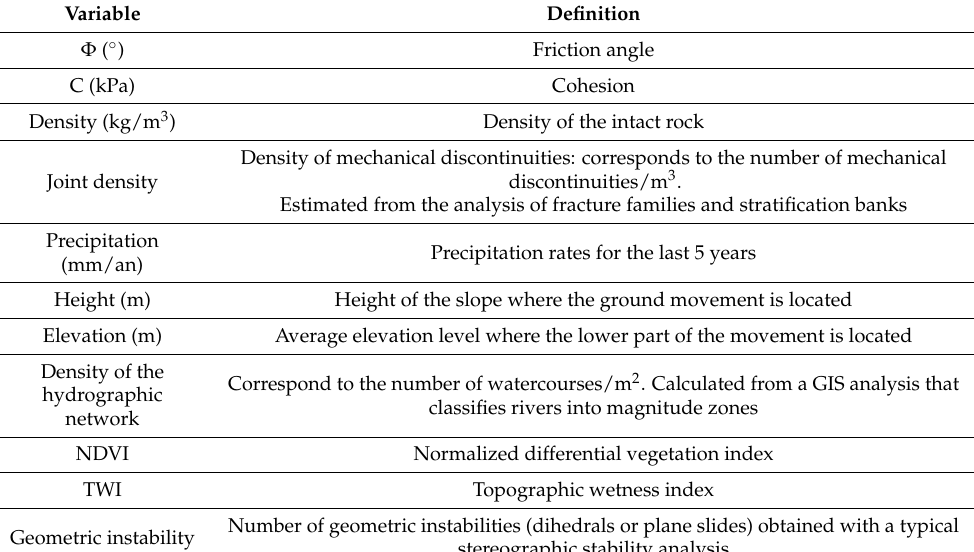
Table 2. Definition of the PCA variables also used in Appendix A (Tables A2 and A3). Variable